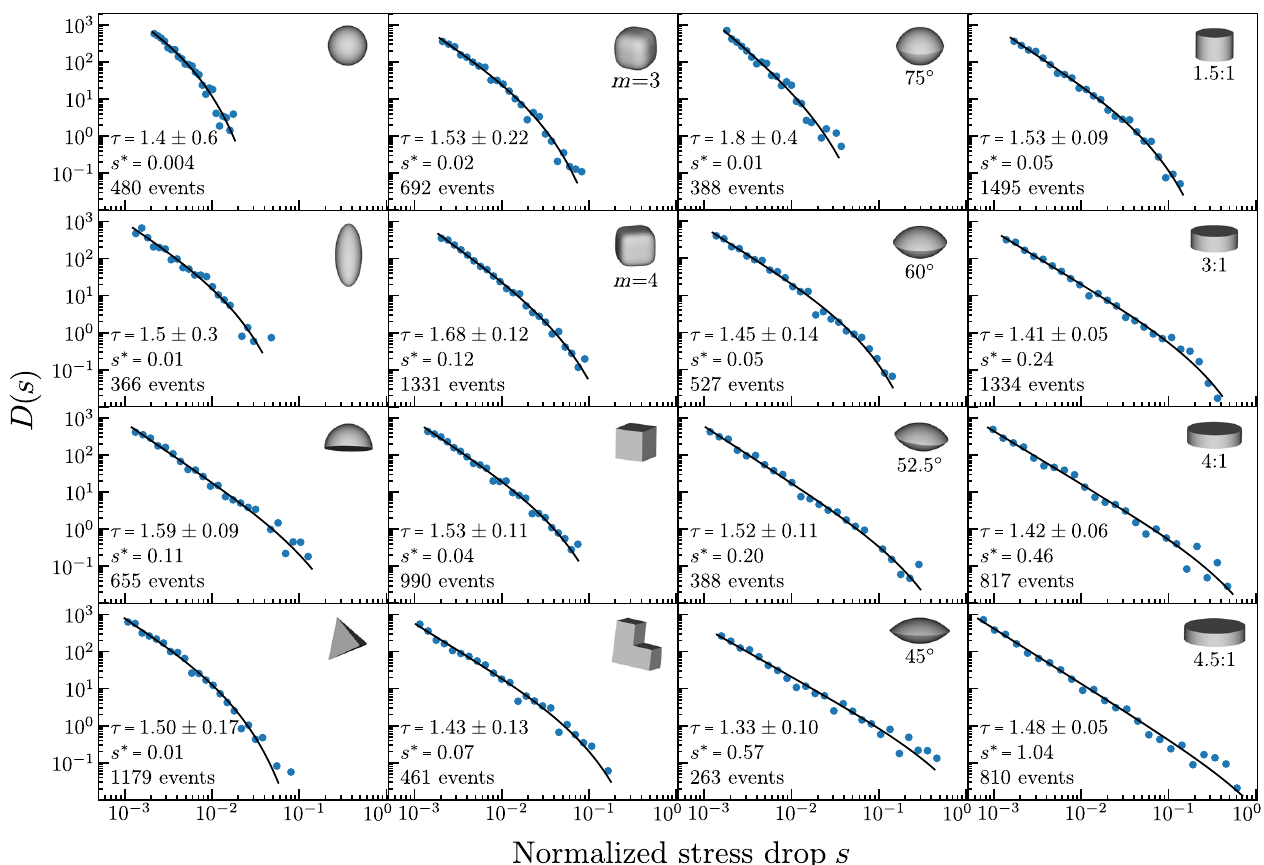
FIG. 5. Stress drop magnitude distributions. The drop distributions were fit by maximum likelihood estimation to a truncated power law of the form D ð s Þ ∼ s − τ exp ð − s=s (cid:2) Þ . The values cited for the uncertainty on τ are 2 σ for the marginal distribution, and only the best- fit value of s (cid:2) is listed. All plots are over the same range. Data points are binned logarithmically (blue) after fitting (black). The distributions are organized by (from left to right) the first column containing spheres, simple deviations from a sphere, and tetrahedra, the second column cubes and simple deviations from a cube, the third column the lens family, and the fourth column the disk